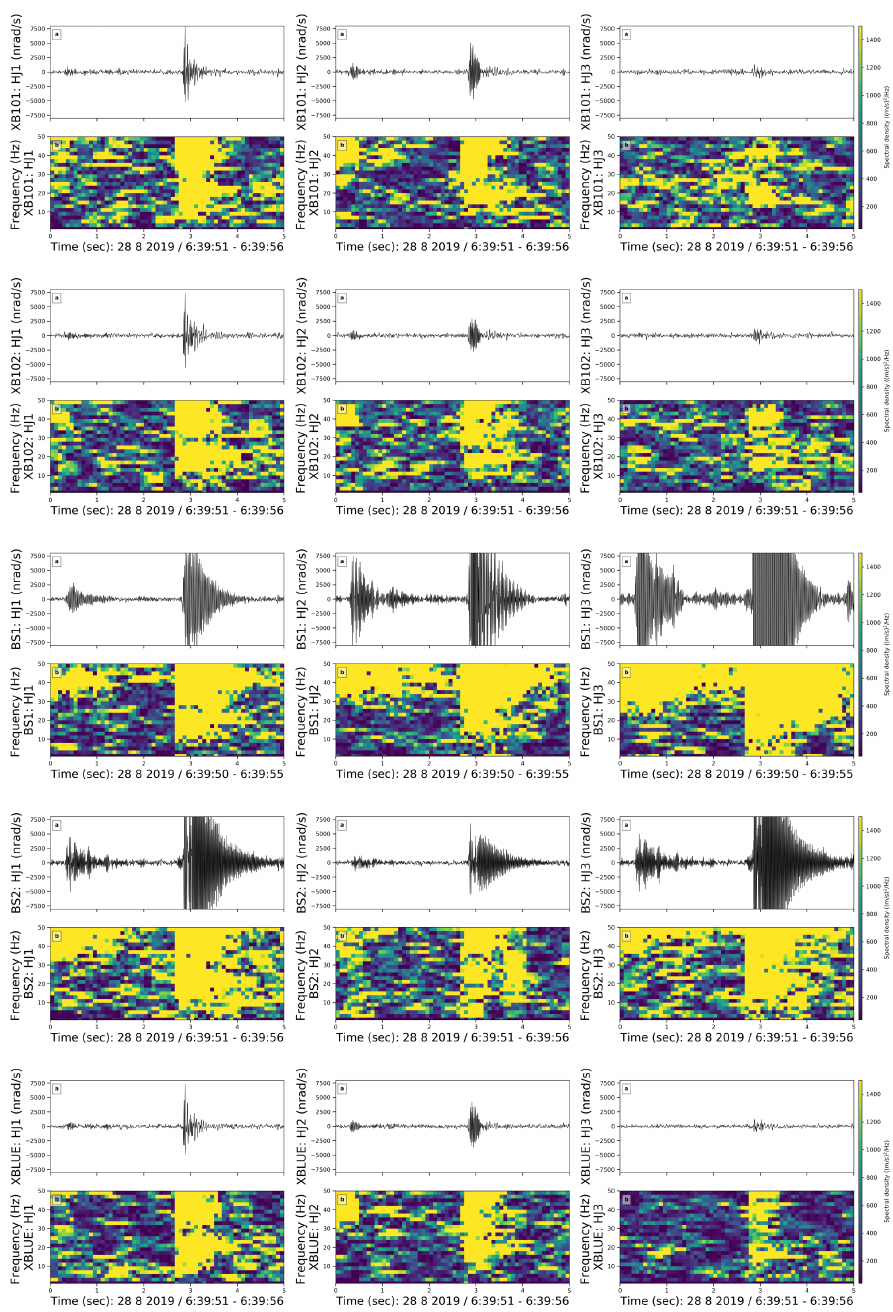
Figure 9. Very short noise in a 5 s long time window on doy 240, i.e., 28 August, Wednesday. The subfigures and colors are the same as in Figure